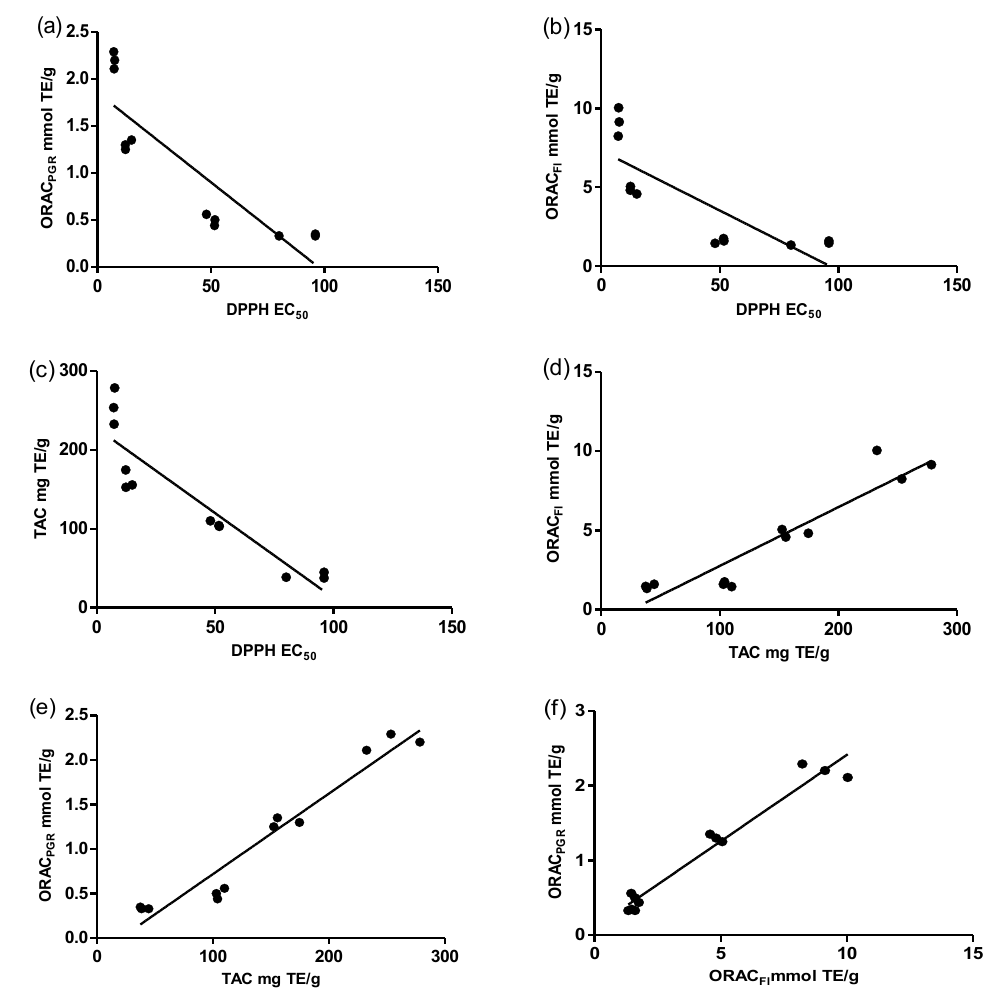
Figure 5. Spearman’s correlation between different antioxidant methods. ( a ) ORAC PRG vs. DPPH ( r = −0.94; p < 0.0001); ( b ) ORAC Fl vs. DPPH ( r = −0.86; p = 0.0003); ( c ) TAC vs. (DPPH) ( r = −0.96; p < 0.0001); ( d ) ORAC Fl vs. TAC ( r = 0.87; p = 0.0002); ( e ) ORAC PRG vs. TAC ( r = 0.95; p < 0.0001); ( f ) ORAC PRG vs. ORAC Fl ( r = 0.84; p =